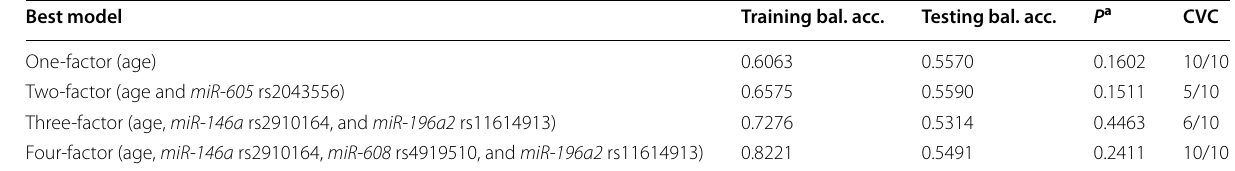
Training bal. acc. training balanced accuracy, Testing bal. acc. testing balanced accuracy, CVC cross-validation consistency a P values for testing balanced accuracy